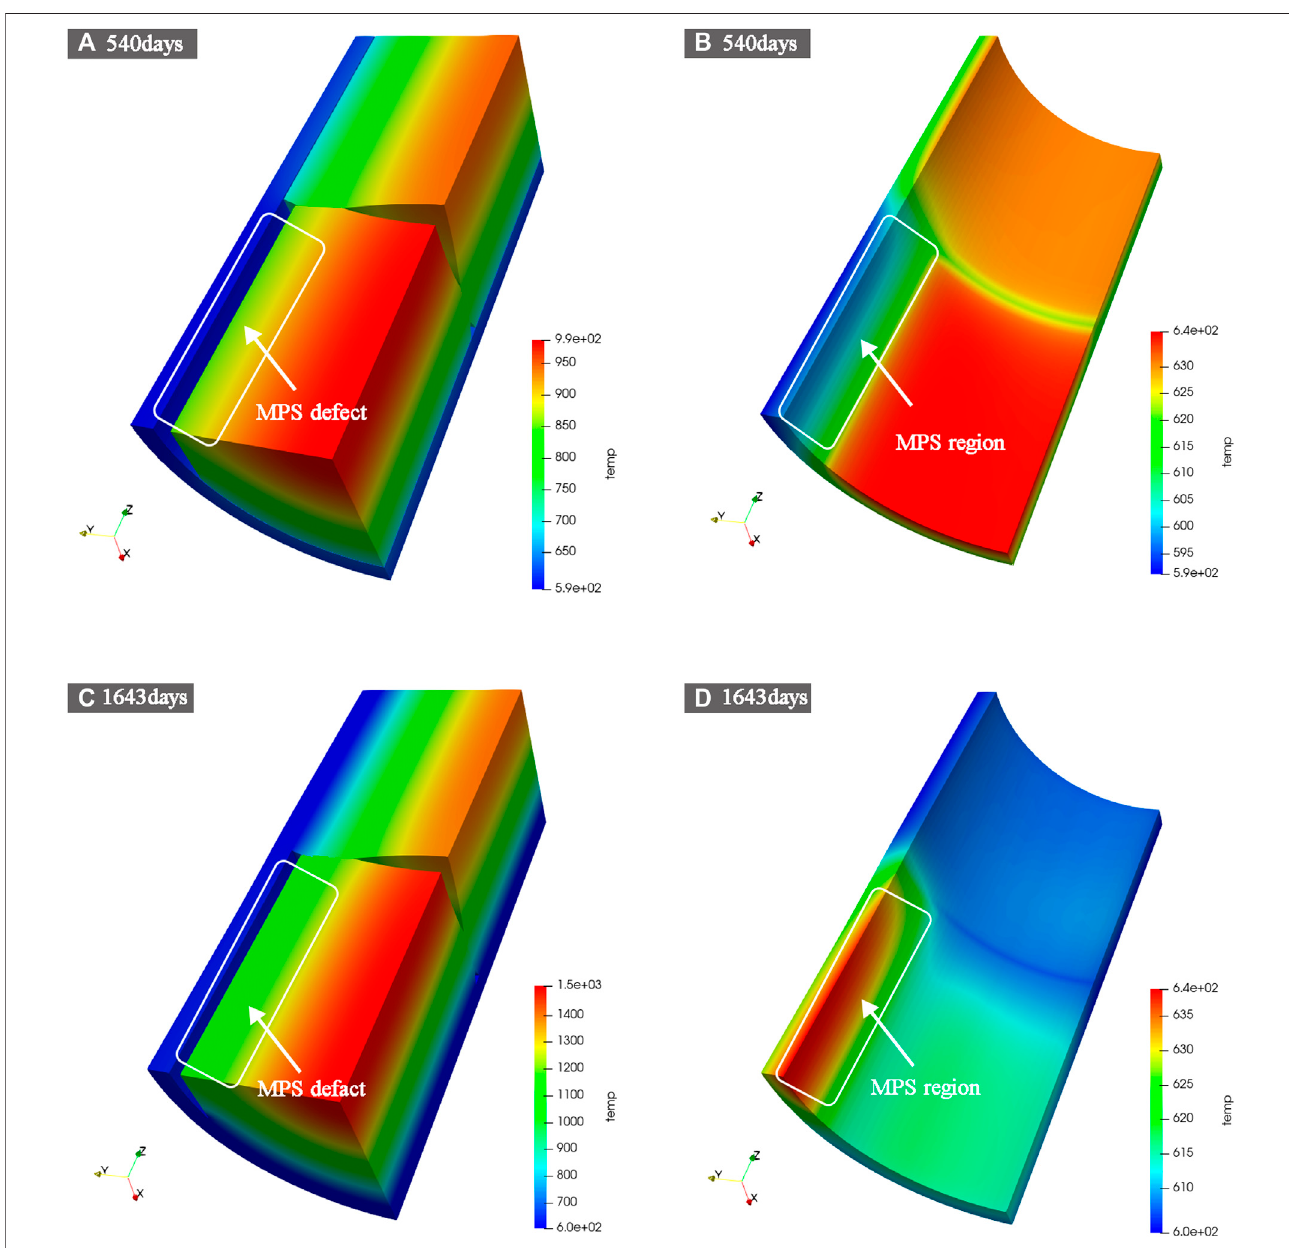
FIGURE 10 | The temperature distribution of fuel rod and cladding at the initial 540 days of reactor operation life and at 1,643 days the end of ramp test.